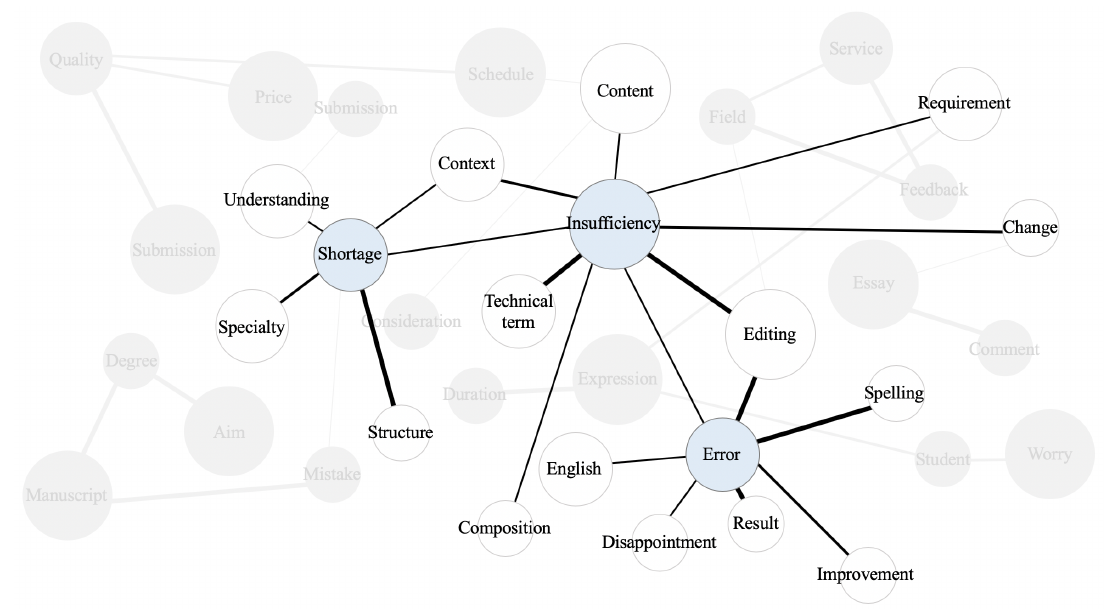
Figure 1. Co-occurrence network of keywords constructed by analyzing negative review texts (ordinal ratings under 3) collected from a manuscript editing service. The size of a node and the thickness of an edge respectively represent the frequency of a keyword and the co-occurrence frequency of the two connected